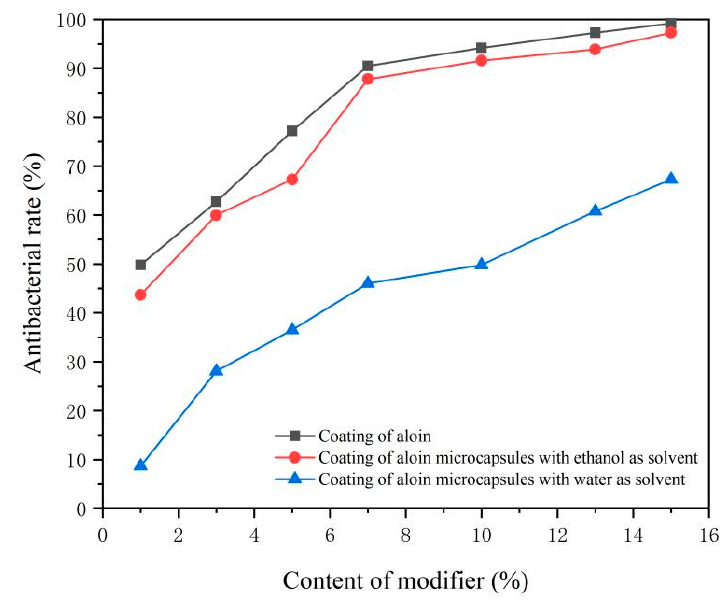
Figure 10. Antibacterial rate of the coating surface with different content of modifiers.